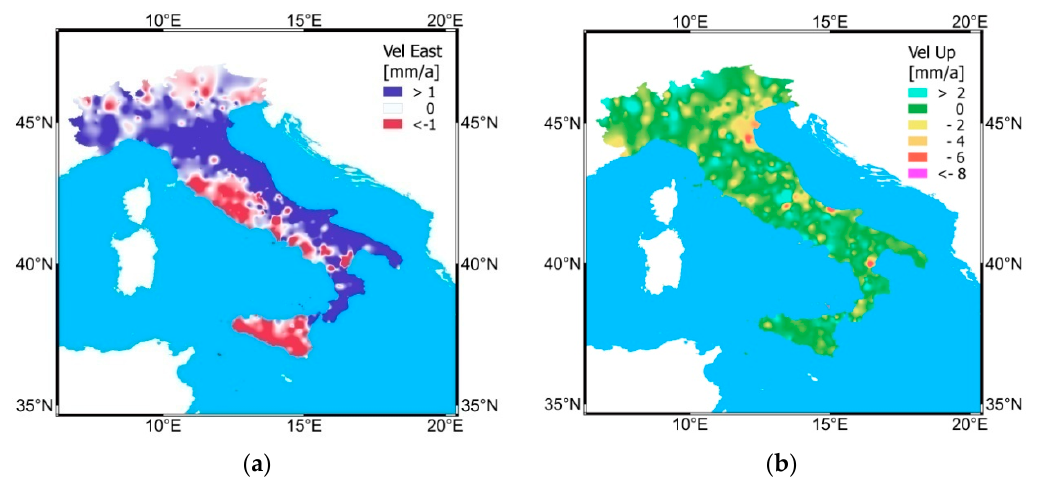
Figure 5. East ( a ) and vertical component ( b ) of velocity correction to apply to PS radar interferometry velocities derived by their calibration with GNSS permanent stations.